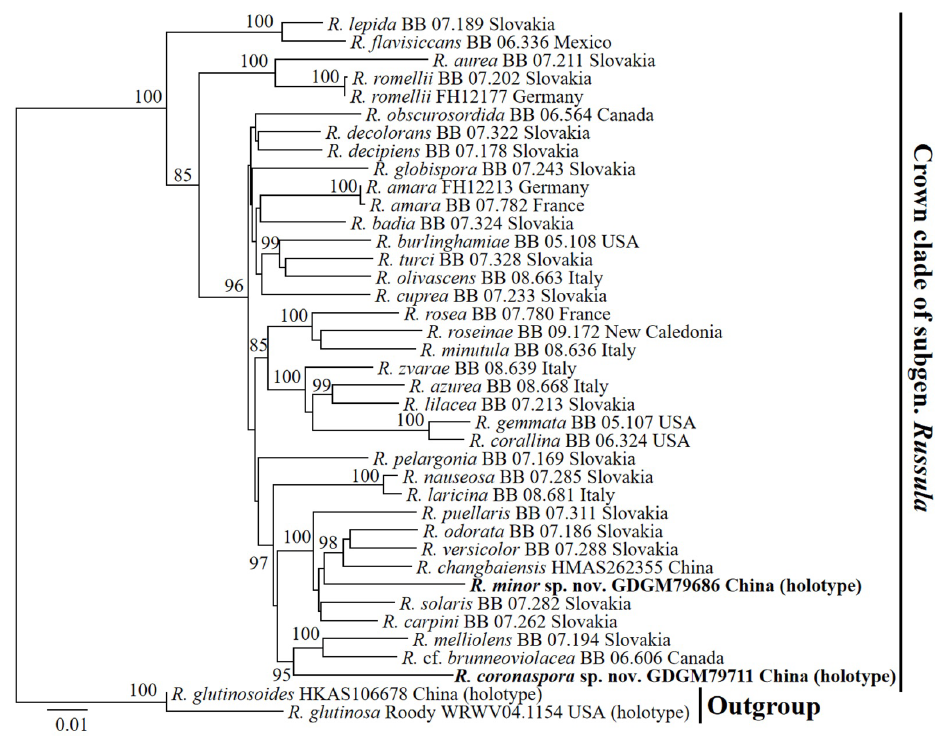
Fig. 2. Maximum Likelihood tree of subgen. Russula crown clade based on 5-locus (nLSU-mtSSU- tef1 - rpb2 - rpb1 ) combined sequences, bootstrap values higher than 70% were displayed around nodes. Collections of the two novel species are shown in